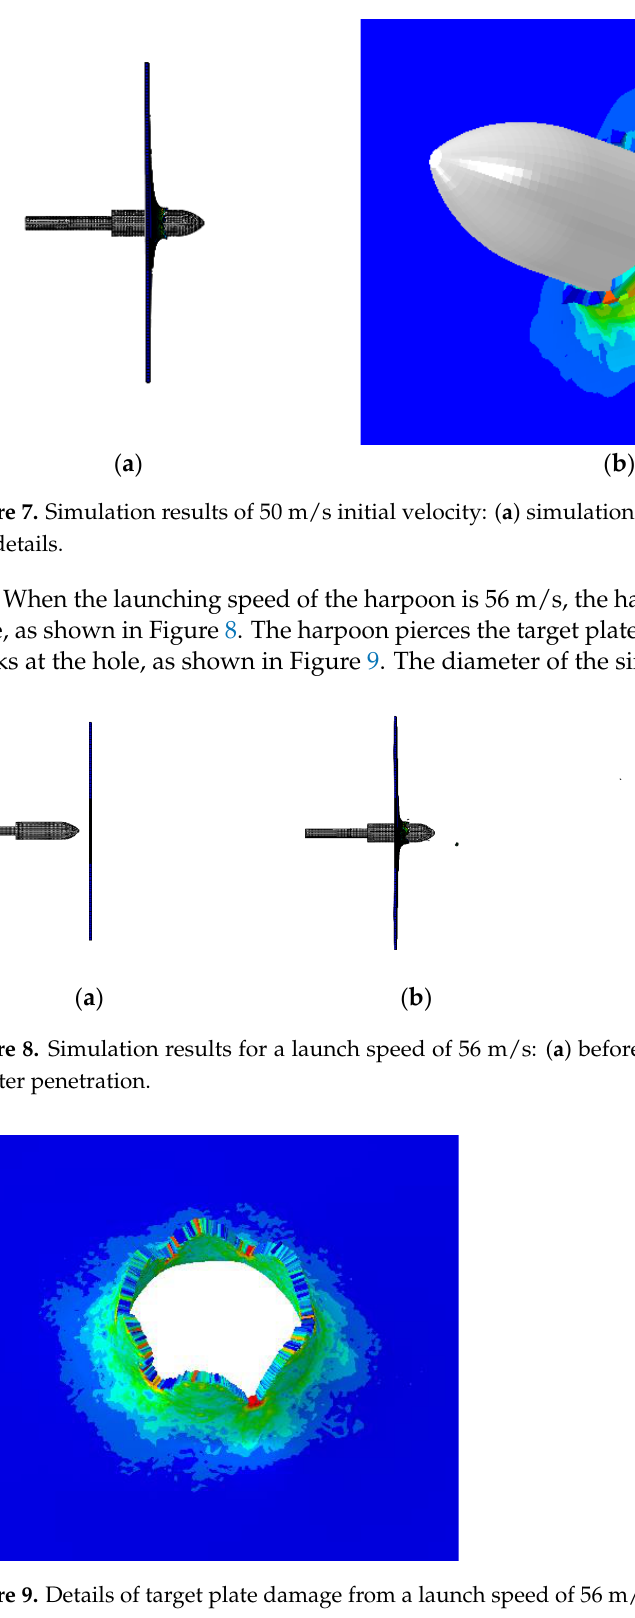
Figure 7b. The error between the simulation results of the harpoon’s speed embedding into the target and the theoretical results of the ballistic limit is 9.1%.